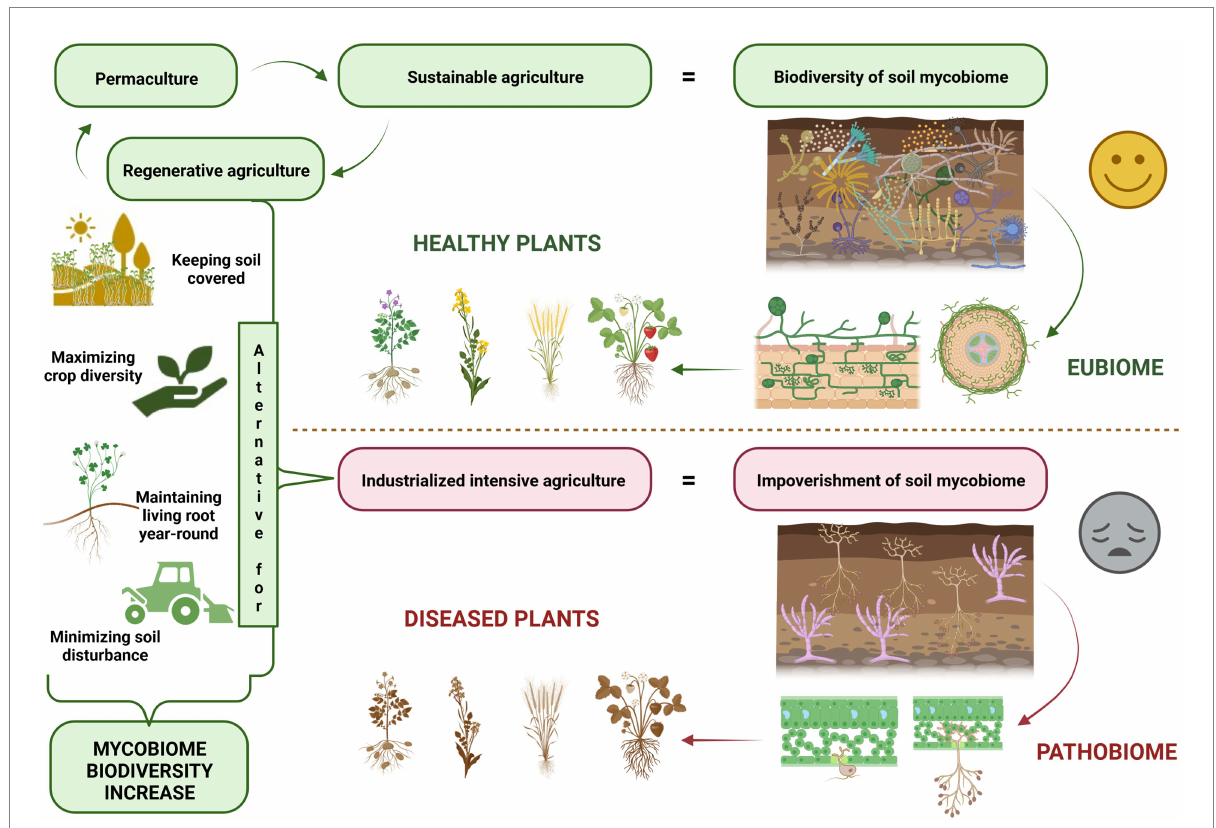
FIGURE 1 Soil mycobiome plays a vital role in sustainable agriculture, horticulture, and